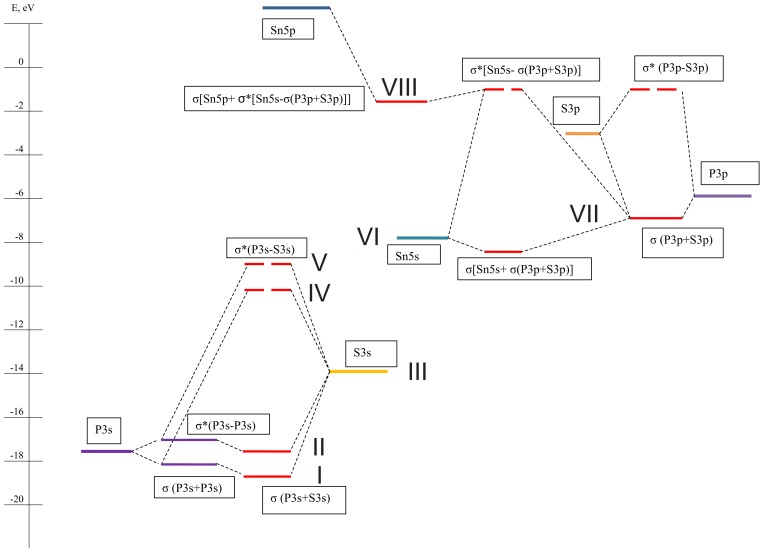
The hybridization scheme for electronic orbitals in Sn2P2S6 crystal.